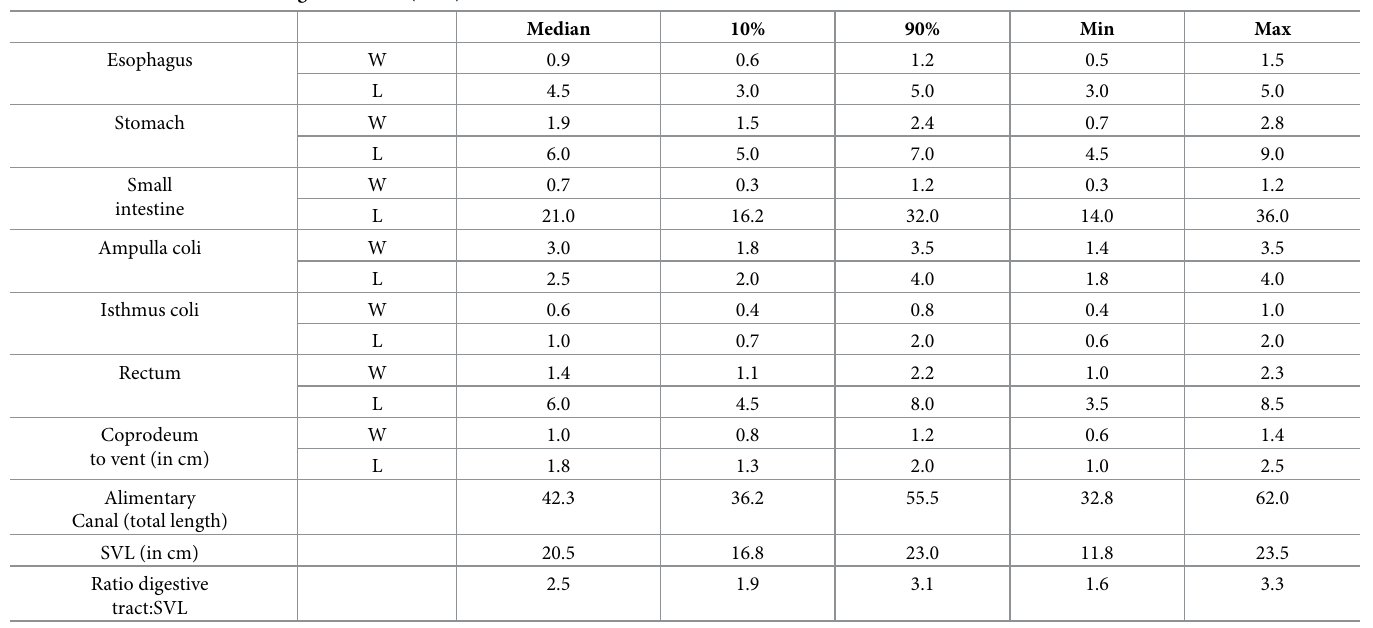
Table 1. Data of adult bearded dragon cadavers